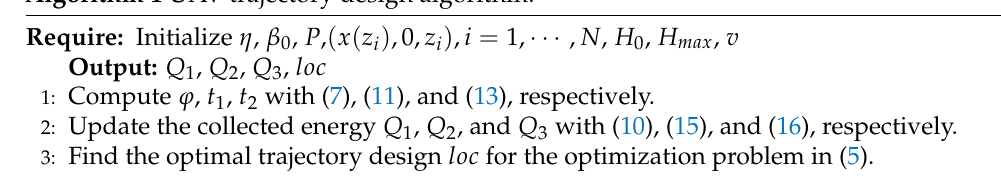
Algorithm 1 UAV trajectory design algorithm.